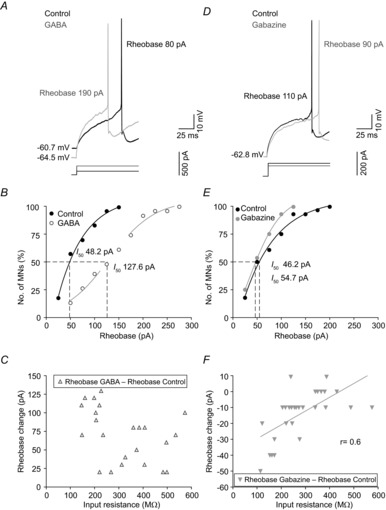
Effects of GABA (100 μm) or gabazine (20 μm) on the rheobase of MNs from the rat oculomotor nucleusA and D, minimum current (rheobase) required to evoke an action potential under control conditions and in response to GABA (A) or gabazine (D) in two different MNs. B and E, cumulative normalized plots of rheobase under control conditions and during exposure to GABA (B) or gabazine (E). The dashed lines show the rheobase (I50) values at which 50% of MNs fired off an action potential. C and F, relationship between input resistance under control conditions and rheobase change in response to exposure to GABA (C) or gabazine (F). MNs, motoneurons.